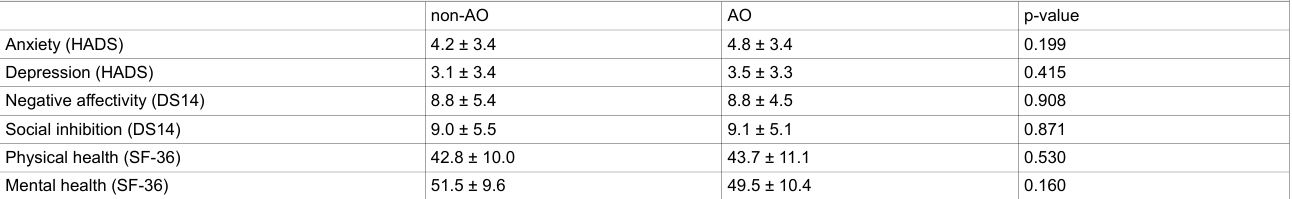
Table 4: Hospital Anxiety and Depression Scale (HADS), Type D personality score (DS14) and Short-form 36 Health Survey (SF-36) in abdominally obese (AO) versus non-AO patients (all analyses were adjusted for obesity measured by